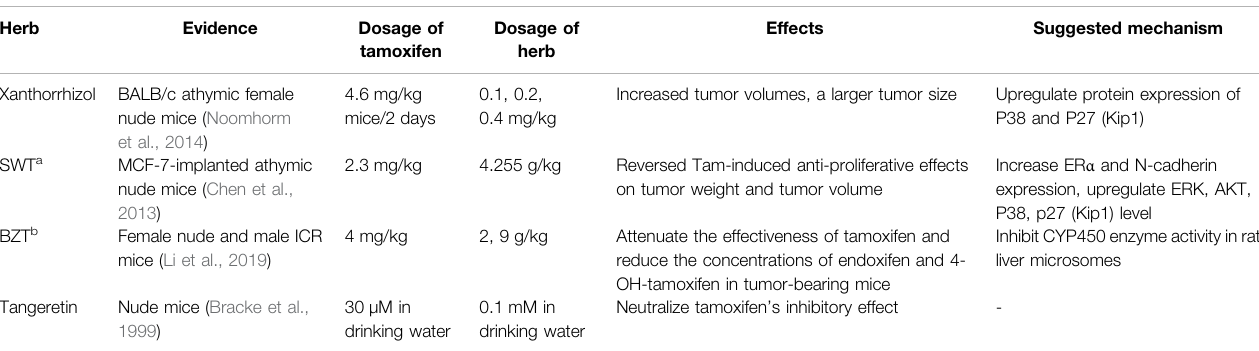
TABLE 6 | Reported evidence of reducing anti-cancer